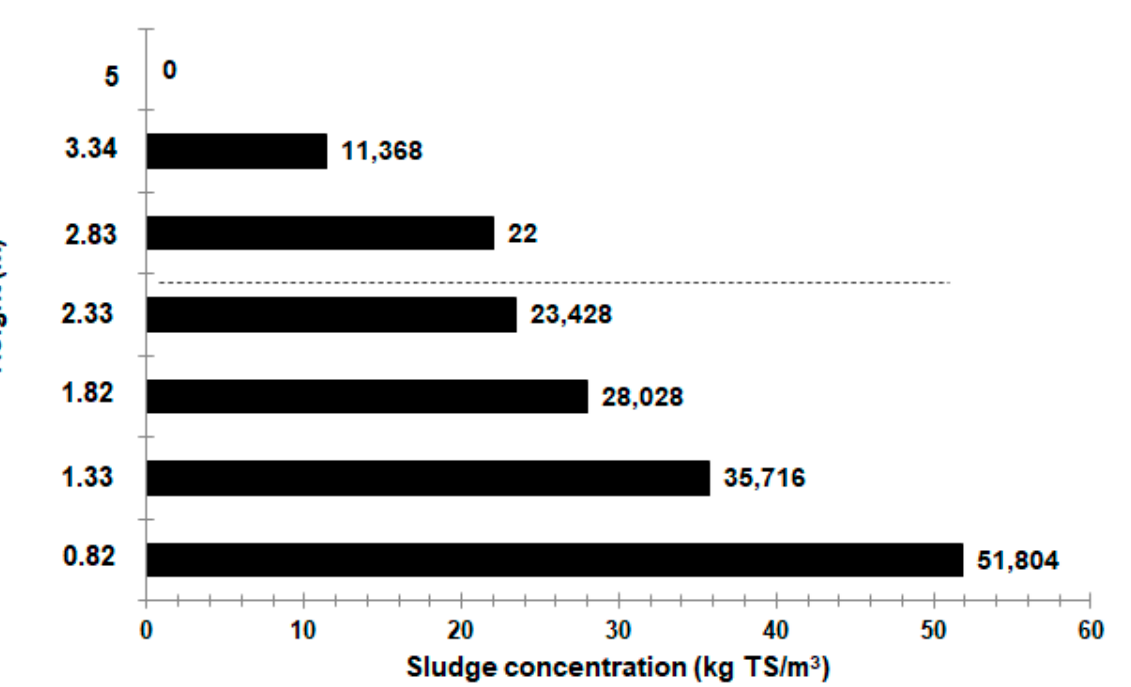
Figure 4. Variation in settleable solids in the UASB effluent and the dissolved oxygen concentration in the aeration tank.